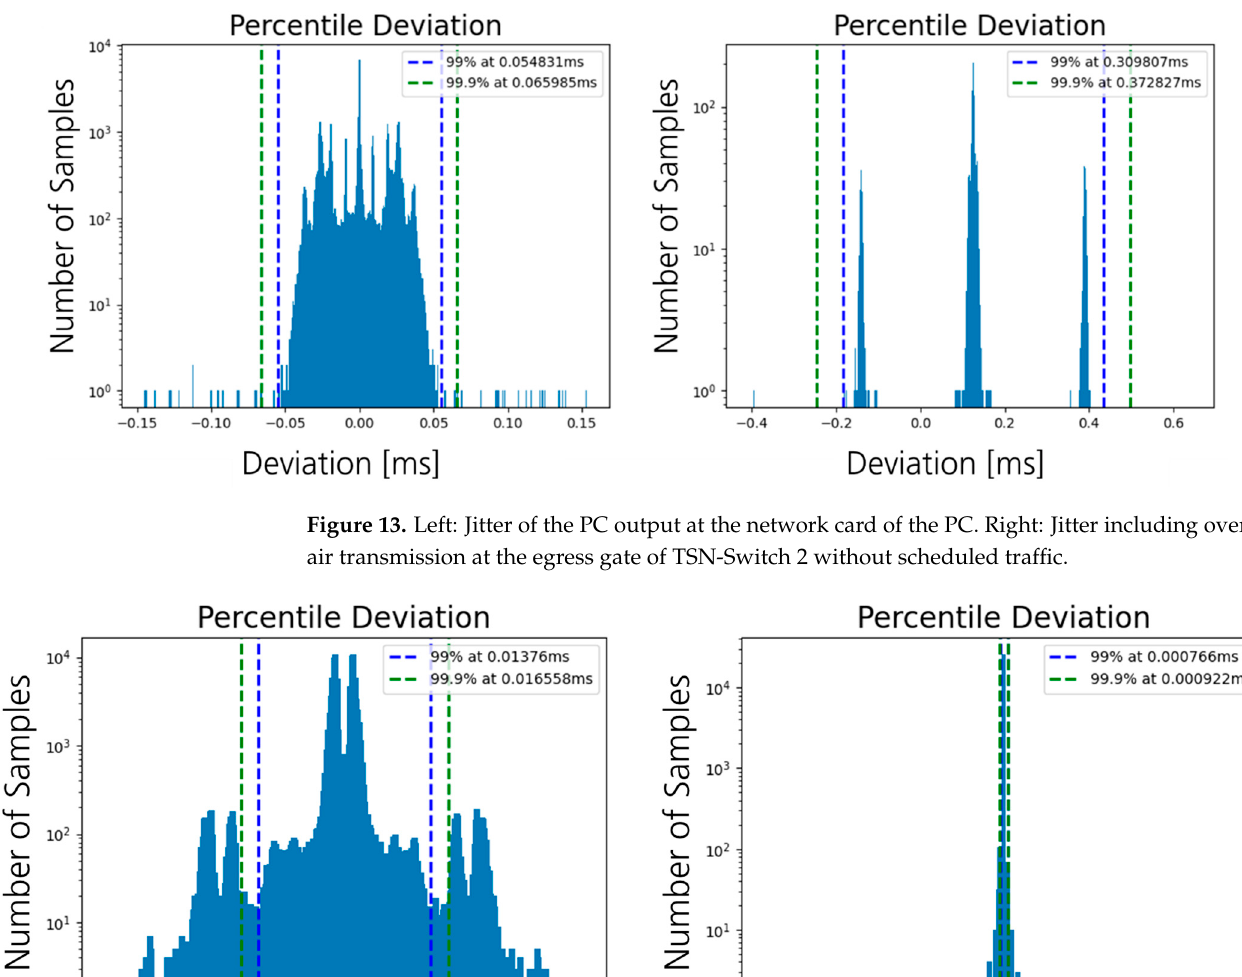
Figure 13. Left: Jitter of the PC output at the network card of the PC. Right: Jitter including over- the-air transmission at the egress gate of TSN-Switch 2 without scheduled traffic.